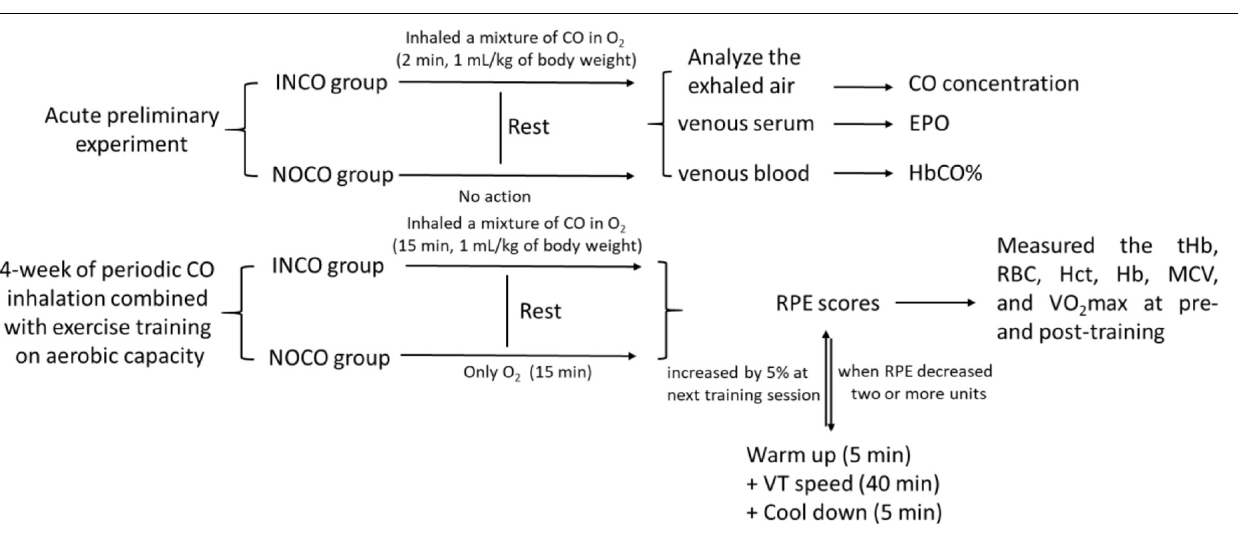
occurred 15 min before commence of the training session. The was maintained for 40 min. 5 min prior to and post each run,